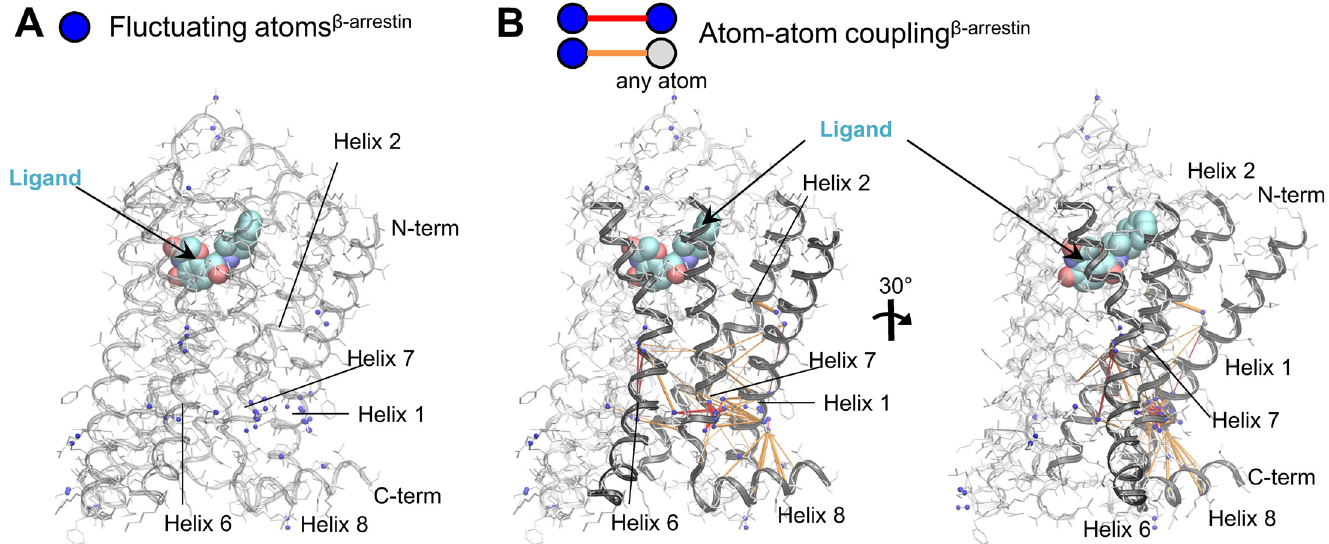
Fig 4. β -Arrestin-linked fluctuating network of β 2 AR. (A) Fluctuating atoms β -arrestin , which have a Pearson ’ s correlation coefficient of more than 0.6 between their Δ RMSF and β -arrestin efficacy, are indicated by blue spheres. (B) Atom – atom couplings β -arrestin were extracted from any pairs containing at least one fluctuating atom β -arrestin by correlation analysis between Δ PCC and β -arrestin efficacy. Lines are depicted in the same manner as in Fig 3.